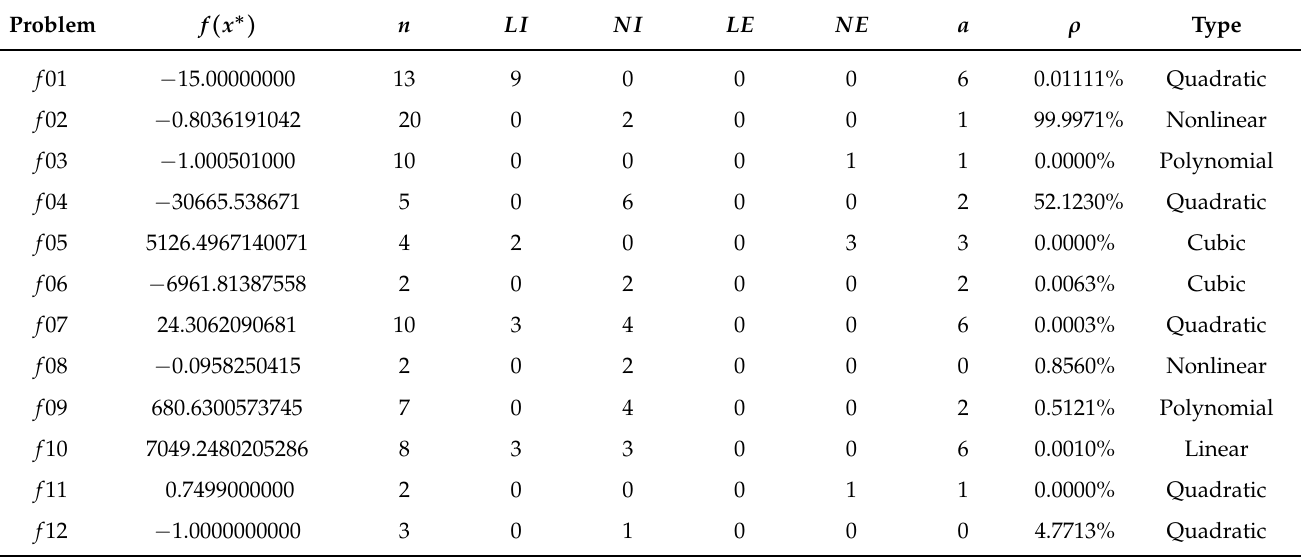
Table 1. The specific characteristics of the 12 benchmark